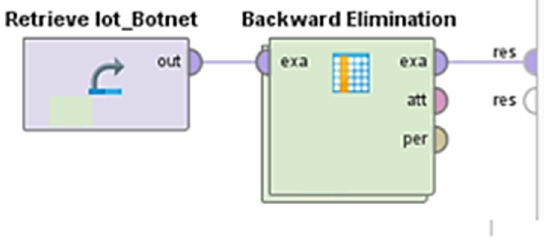
Figure 10. Backward Elimination.